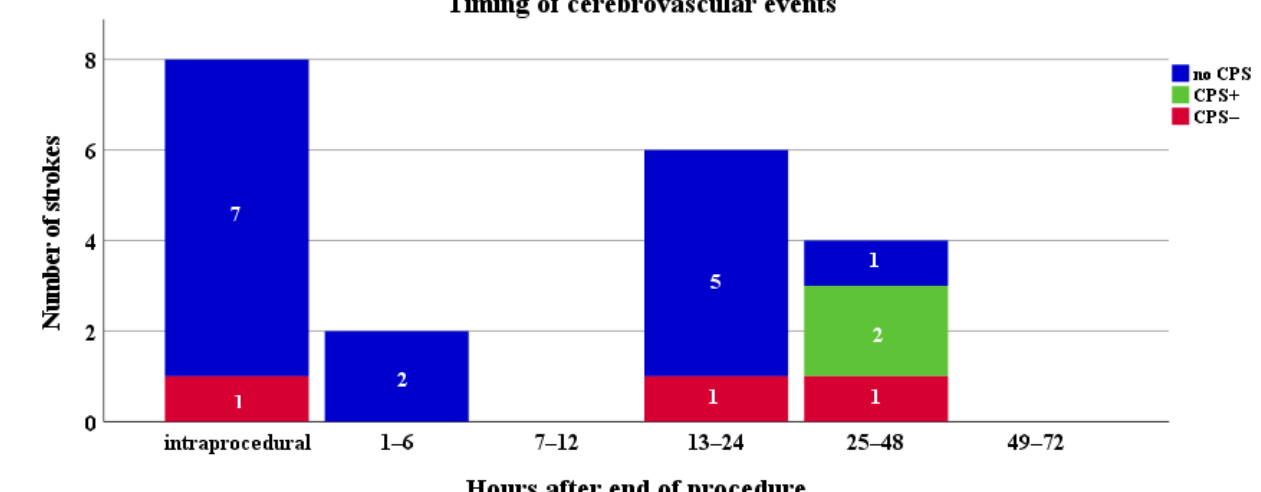
Figure 3. Timing of strokes in patients undergoing TAVR. NoCPS indicates TAVR without Sen- tinel™. Patients in whom both filters were correctly deployed are presented as CPS+, patients with incomplete/incorrect CPS deployment are indicated as CPS−.